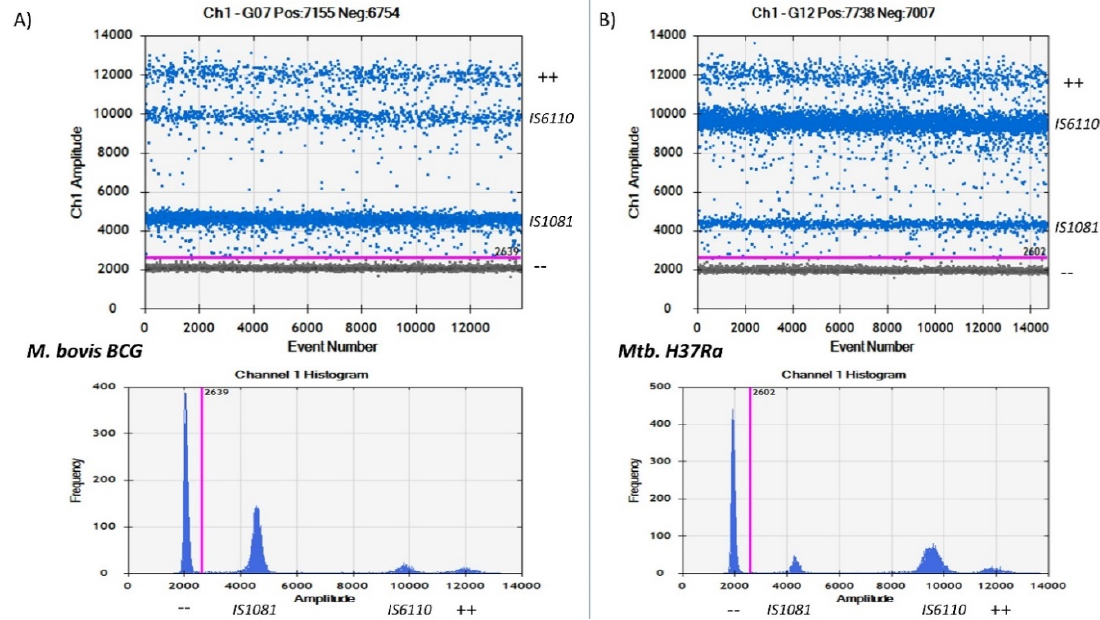
Figure 6. Histogram and 1D droplet concentrations of IS6110 and IS1081 genes based on M. bovis BCG and Mtb. H37Ra strains. ( A ) BCG result showing a high droplet concentration of IS1081 gene than IS6110 gene. ( B ) Mtb. H37Ra result showing a high concentration of IS6110 gene droplets rather than IS1081 gene droplets. In A, a higher concentration of droplets can be clearly observed in the IS1081 gene amplitude in both the histogram and 1D plot when compared to double positive droplets and IS6110 droplet concentrations. For B, the reverse is true. Less droplet concentrations can be observed in the IS1081 and double positive droplets with high concentrations of IS6110 droplets.